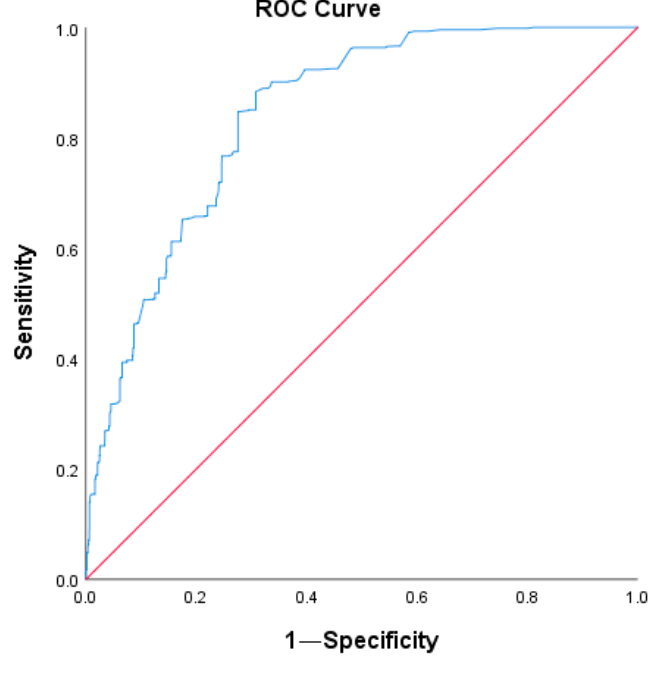
Figure 3. ROC curve.